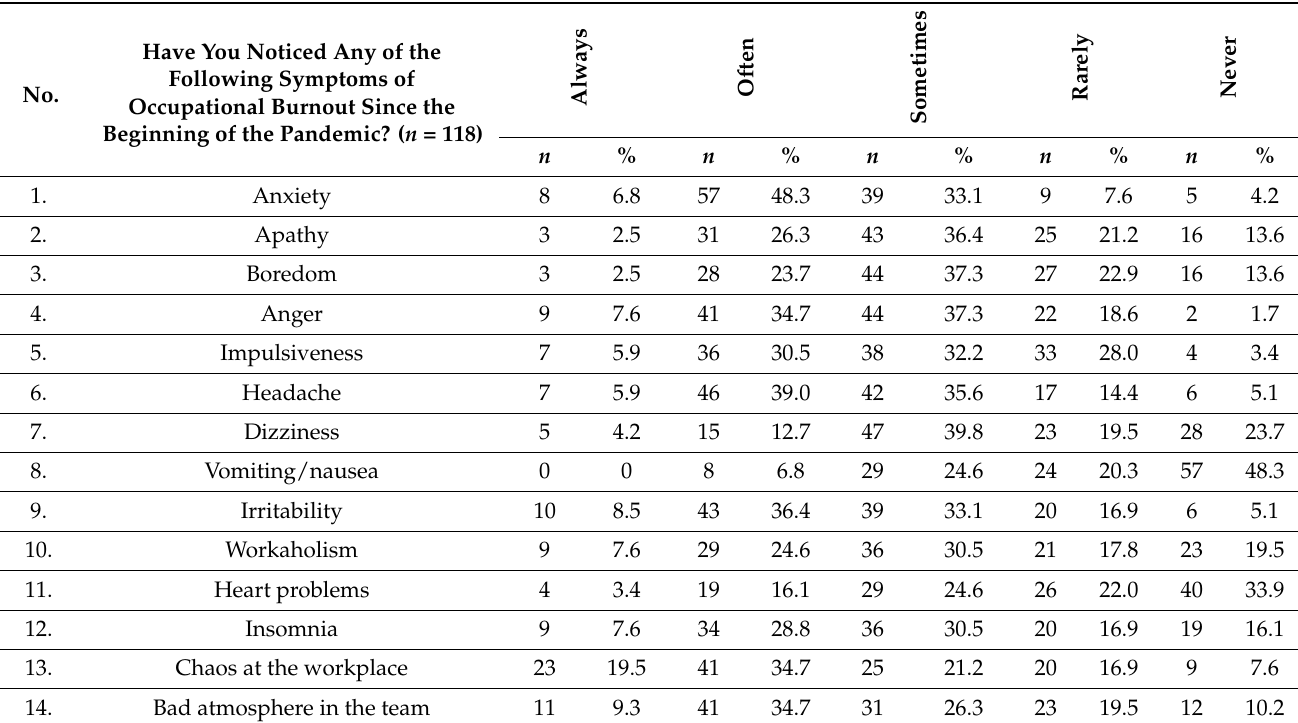
Table 3. How would you rate the level of stress experienced when working with SARS-CoV2